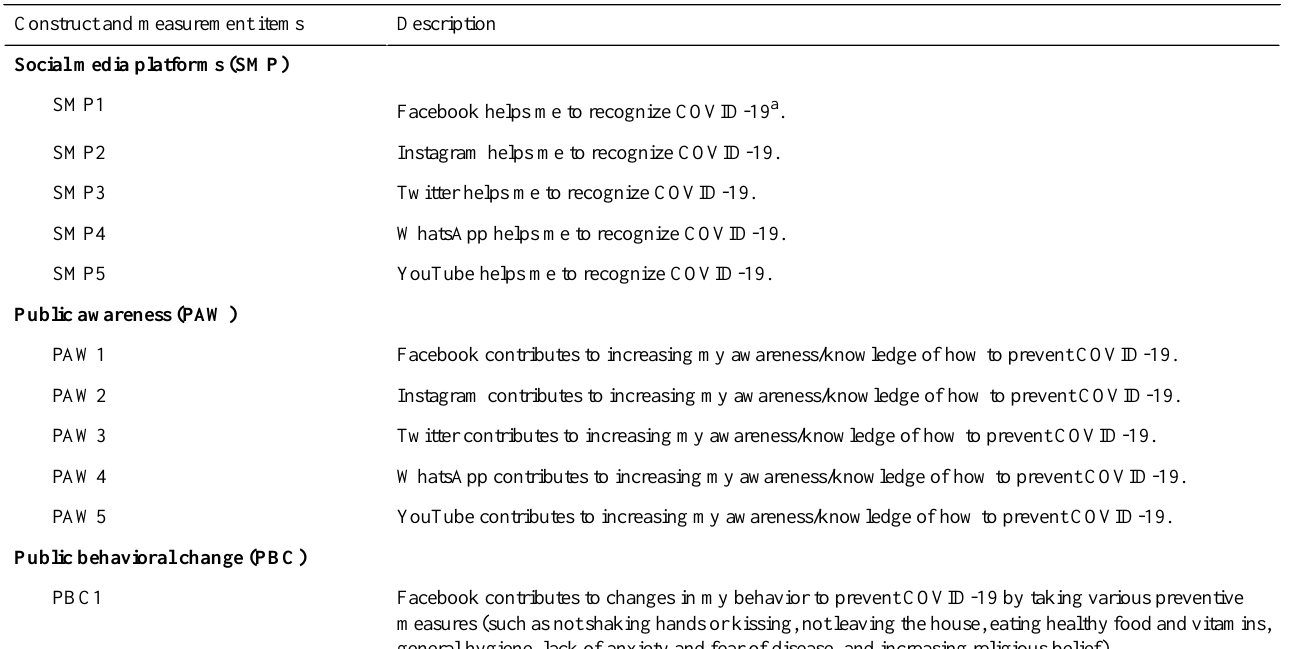
Table 1. Variables and measurement items. DescriptionConstruct and measurement